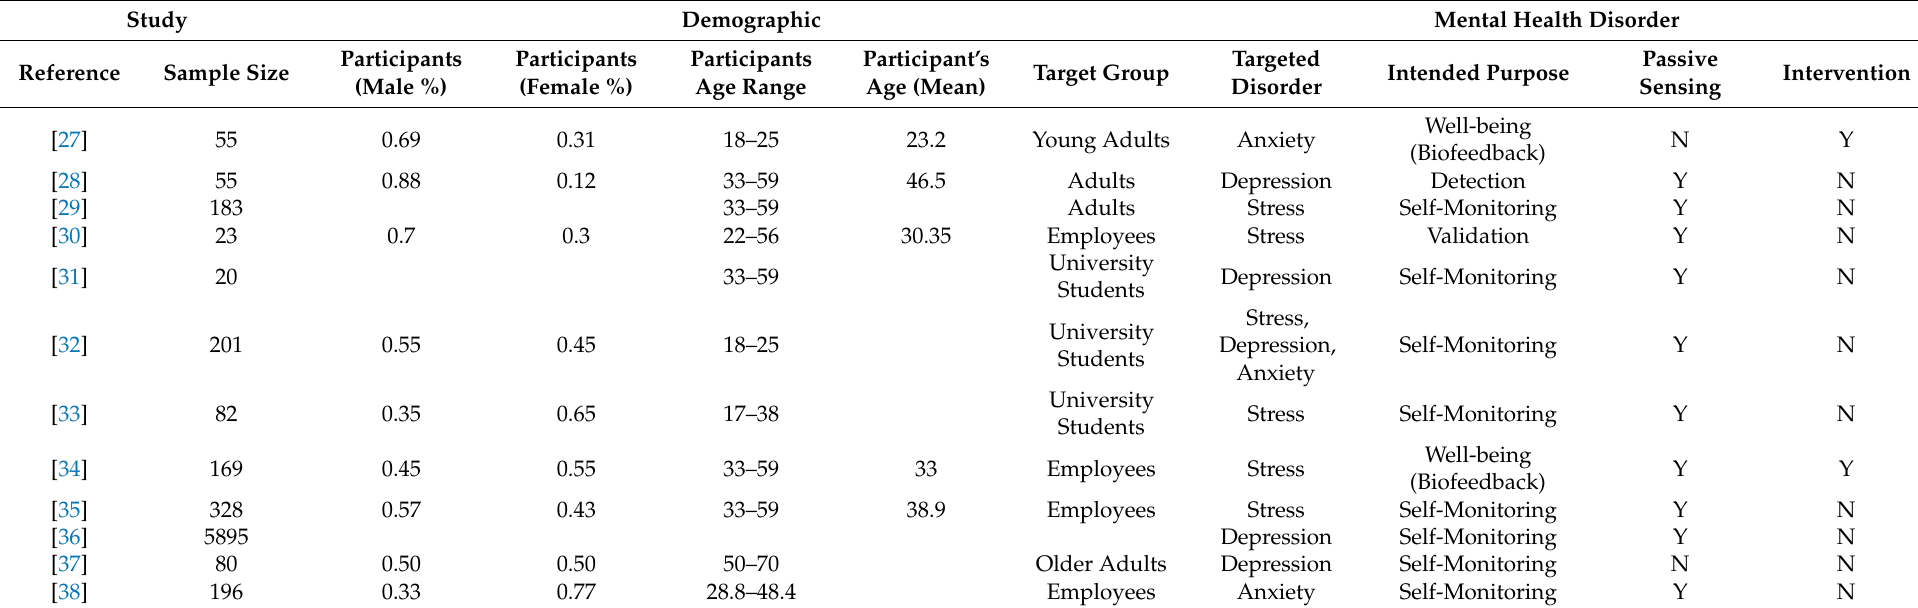
Table 2. Study characteristics including demographic and target mental health